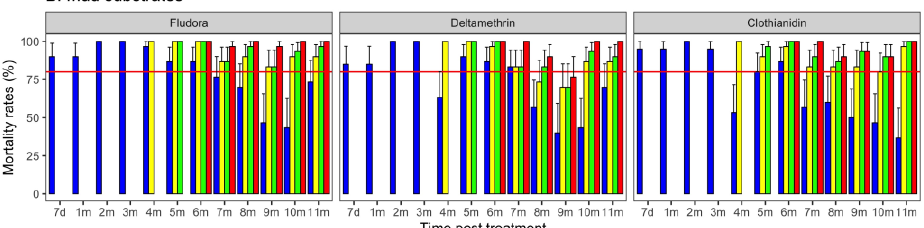
Figure 1. Mortality rates recorded after exposure of the An. coluzzii susceptible colony on cement ( A ) and mud ( B ) supports in the experimental station from the 7th day to the 11th month after the treatments with Fludora ® Fusion, deltamethrin, and clothianidin at 24 h, 48 h, 72 h, and 96 h. The horizontal red line indicates the 80% WHO threshold limit of efficacy. The bars indicate the upper limits of the 95% confidence intervals associated with the mortality